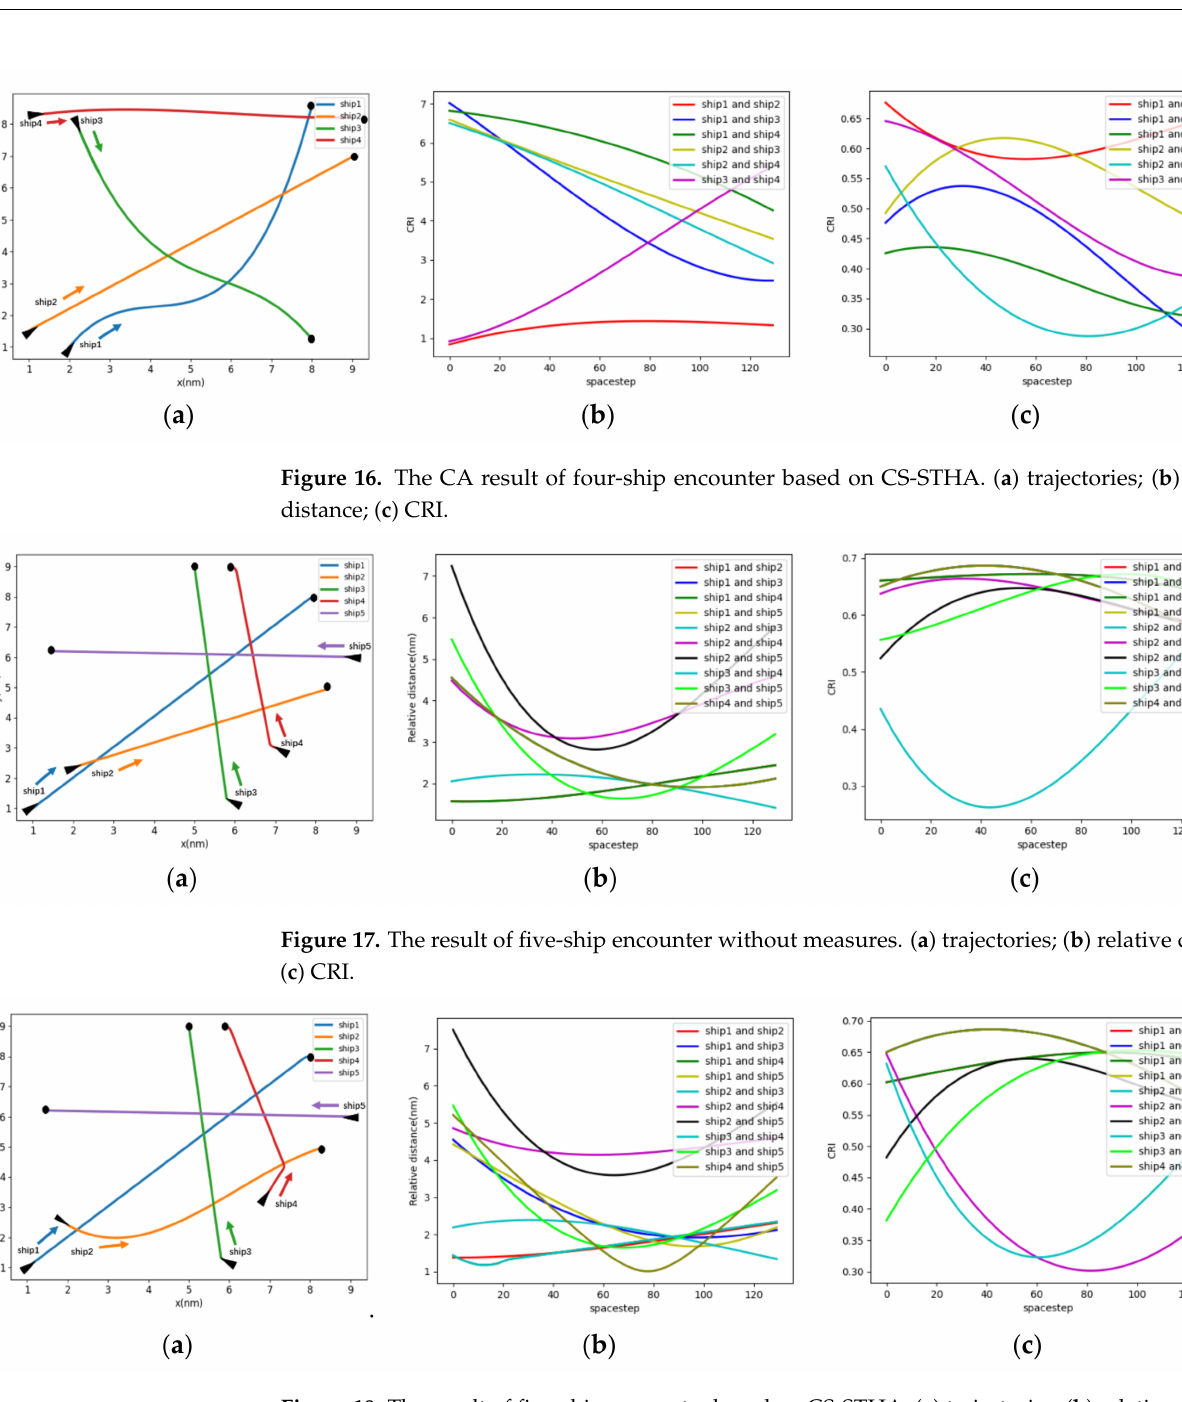
Figure 18. The result of five-ship encounter based on CS-STHA. ( a ) trajectories; ( b ) relative distance; ( c )